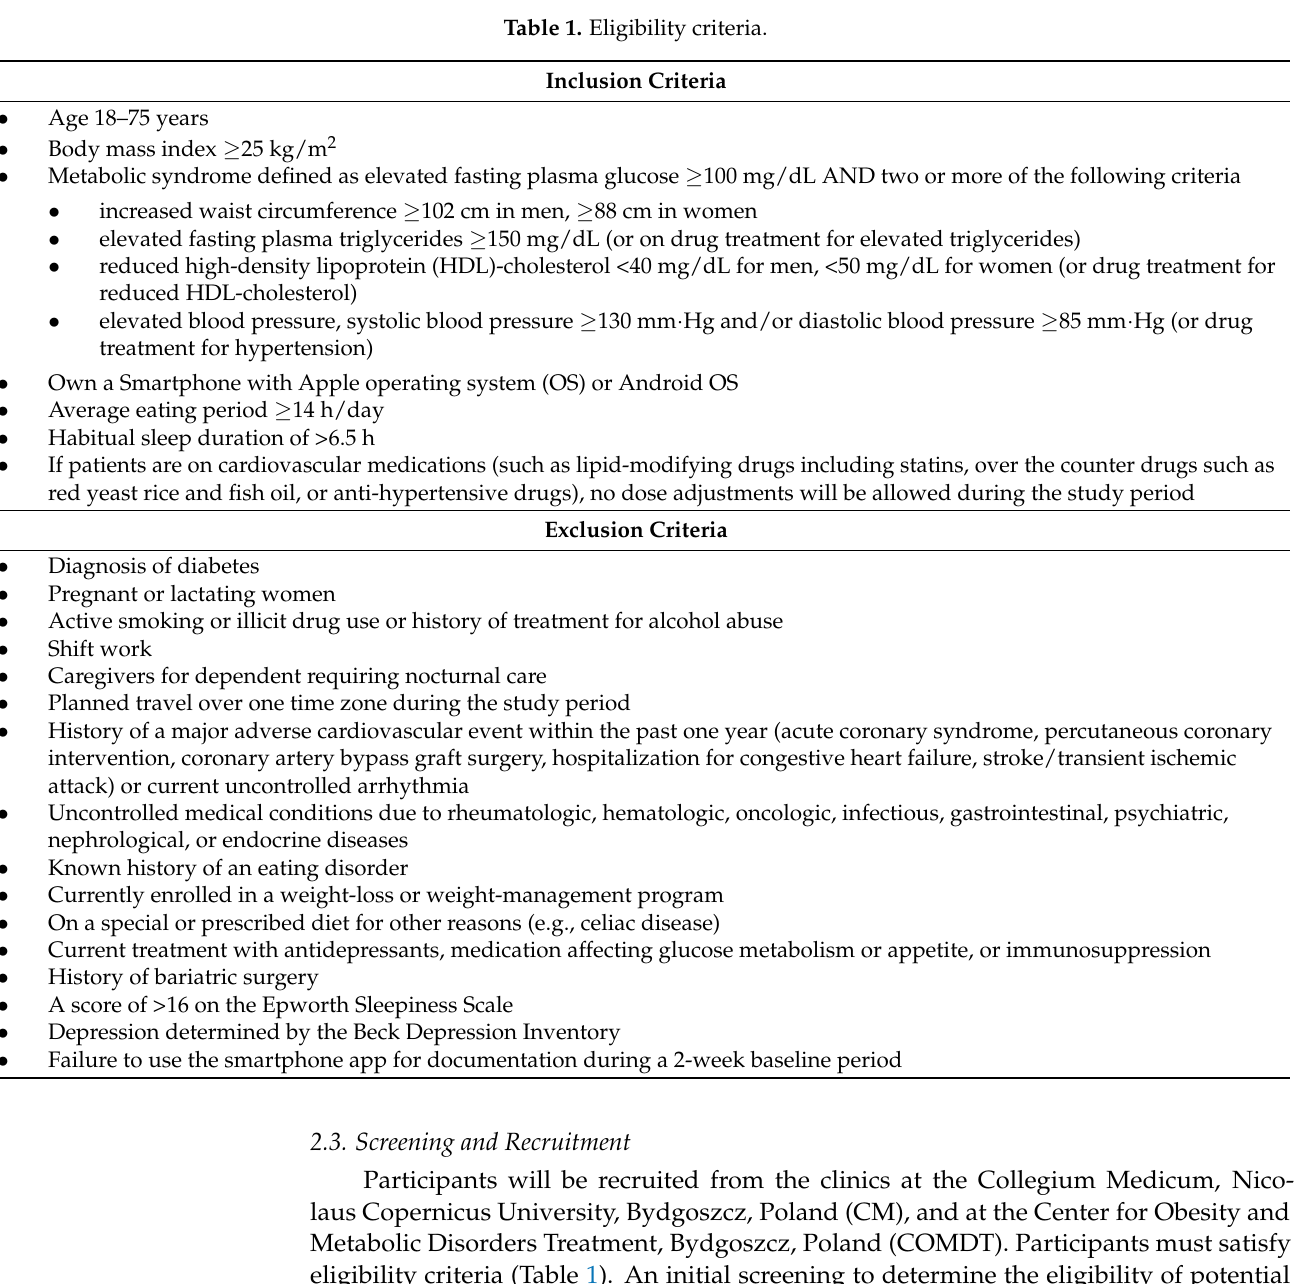
Table 1. Eligibility